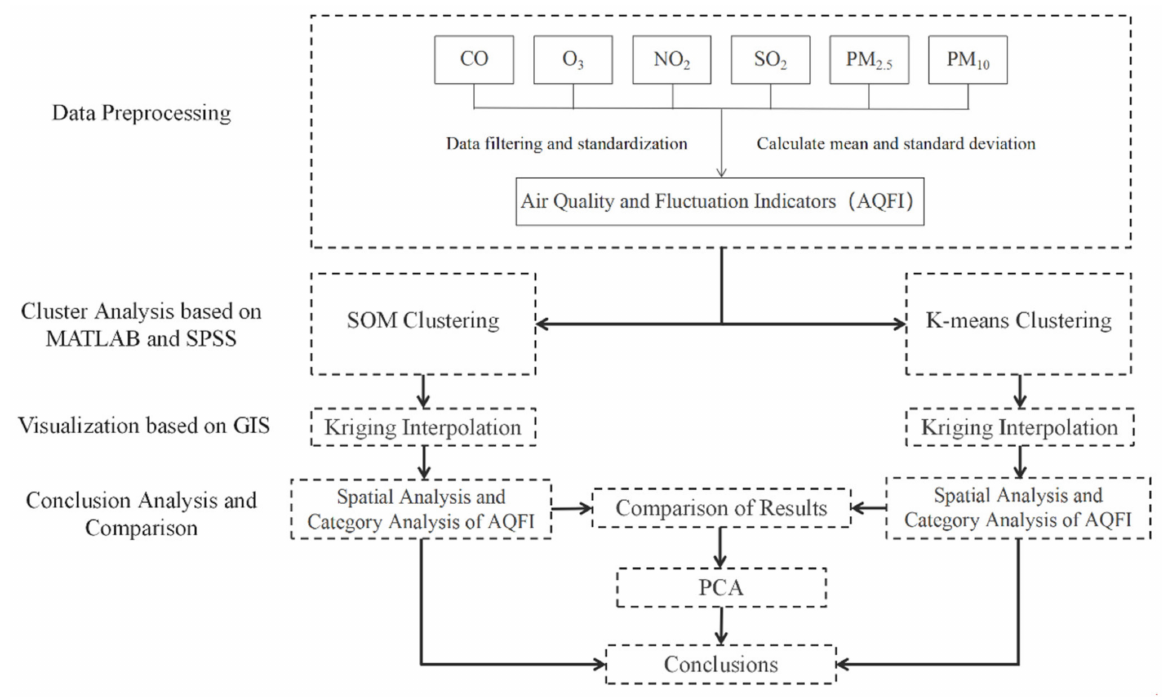
Figure 1. Technology